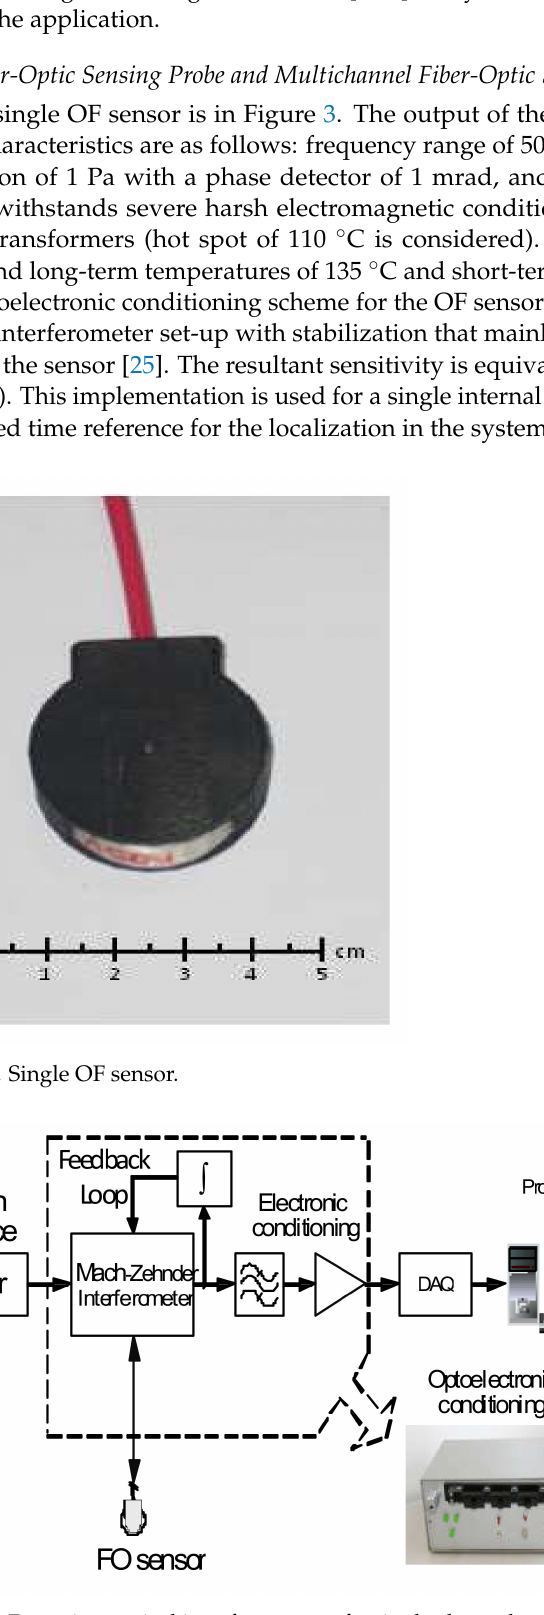
Figure 4. Detection optical interferometer of a single